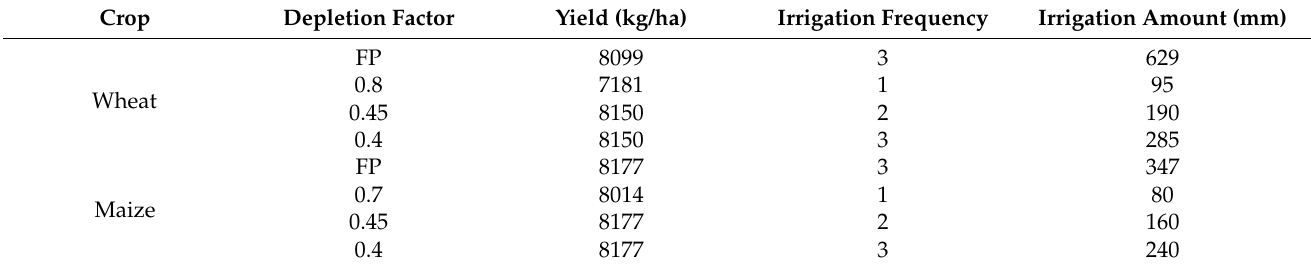
Table 4. Irrigation frequency and amount for different management depletion